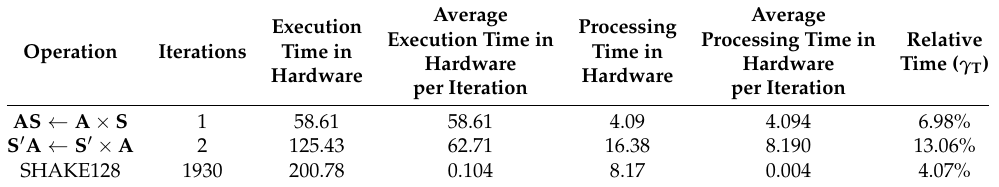
Table 5. Hardware-only execution and processing time, in